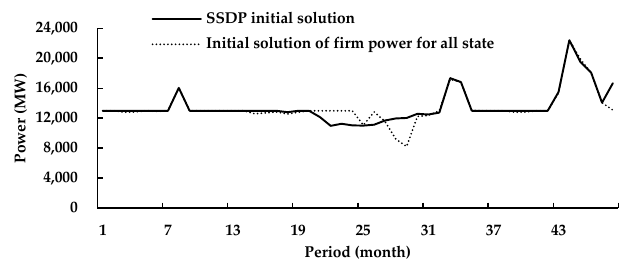
Figure 7. An example of simulation difference of operation rules.